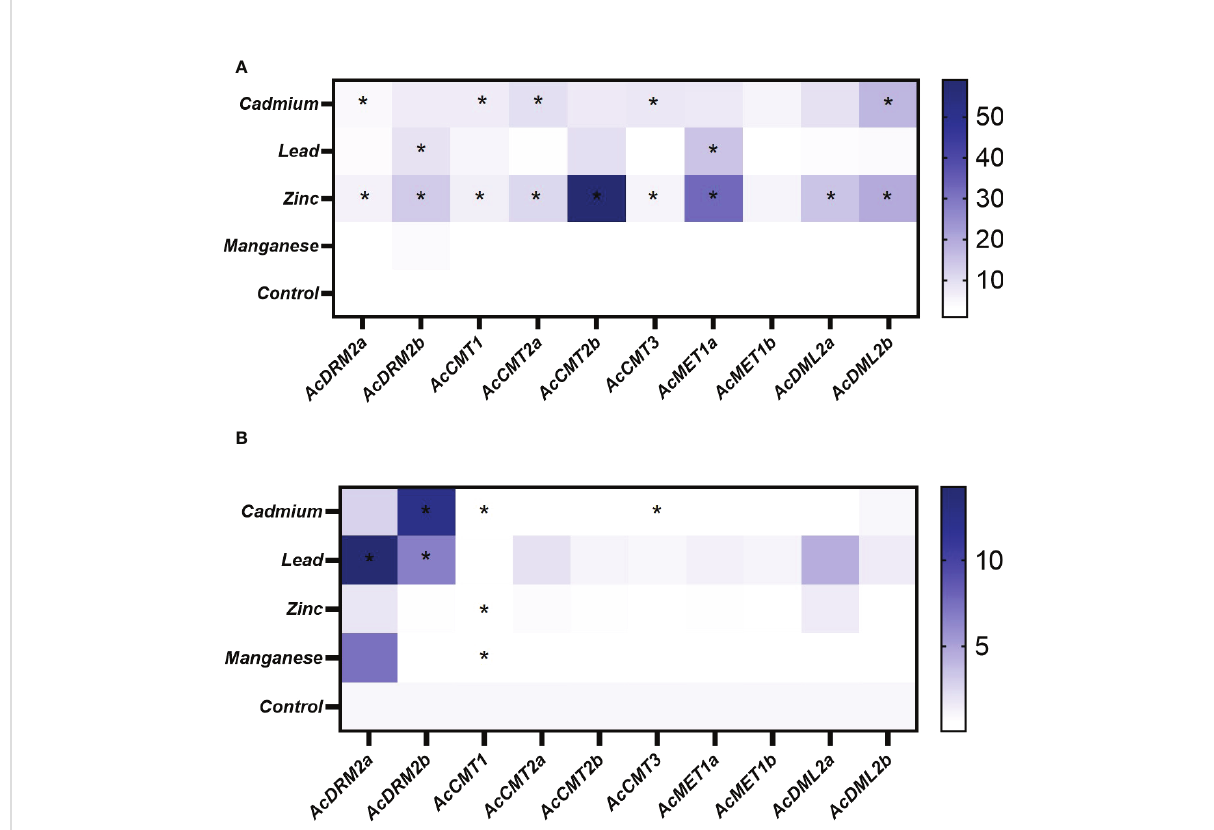
FIGURE 6 Heatmap representation of relative expression data for A. cruentus MTase and DMTase genes in the root (A) and leaf (B) tissues under the various HM stress; asterisks in heatmap show statistical signi fi cance at p < 0.05 based on Tukey ’ s test when comparing HM-treated and control plants. The white and blue scale indicate relative expression to control samples where the expression level was set to